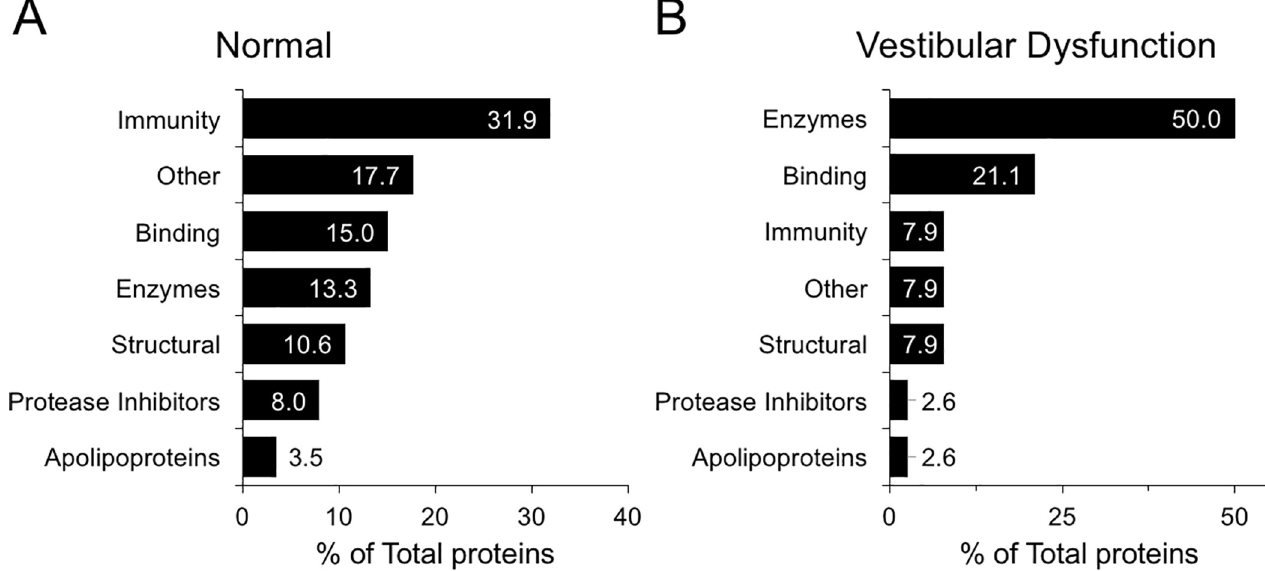
Fig 3. Major protein categories in human perilymph. ( A ) The perilymph of patients with intact hearing. Within each category, the percentage of the total amount of proteins is denoted within each bar. The Other category included proteins involved in ubiquitination, blood coagulation cascade, and receptors. ( B ) Categorization of differentially expressed proteins between perilymph fluid from patients with normal hearing and those with vestibular dysfunction.